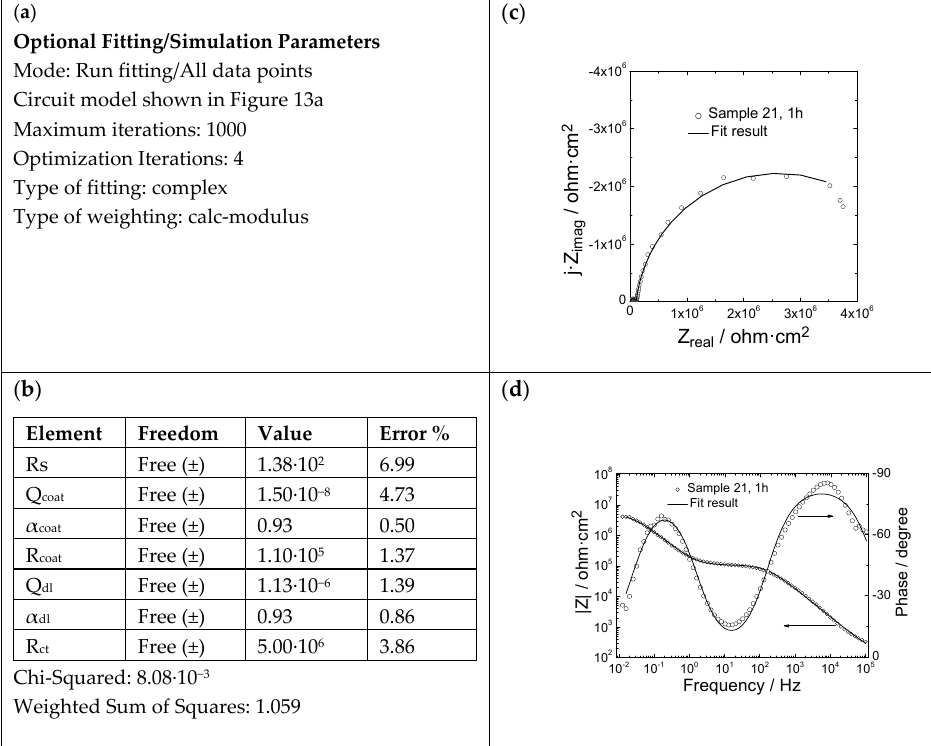
Figure 14. Fitting parameters and results obtained by applying calculous protocols of the ZView ® commercial software, for sample 21 after 1 h of immersion time in 0.05 M NaCl aqueous solution: ( a ) optional fitting parameters; ( b ) values obtained for each element of the equivalent circuit shown in Figure 13a; ( c ) and ( d ) Nyquist and Bode plots of experimental and fitting data respectively.